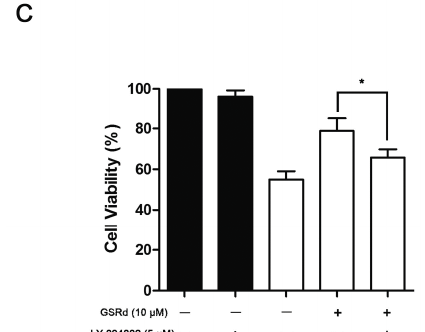
Figure 5. Effects of ginsenoside Rd (GSRd) on Akt phosphorylation in 1-methyl-4- phenylpyridinium (MPP + ) treated SH-SY5Y cells. ( A ) phosphorylation-Akt (P-Akt) and total-Akt (T-Akt) levels were determined by Western blotting; ( B ) P-Akt/T-Akt ratio was presented as folds relative to normal; and ( C ) administration of LY294002 for 12 h prior to GSRd partly blocked the cytoprotective role of GSRd (cell viability was measured by MTT assay). * p < 0.05; and ** p < 0.01 vs. control group.